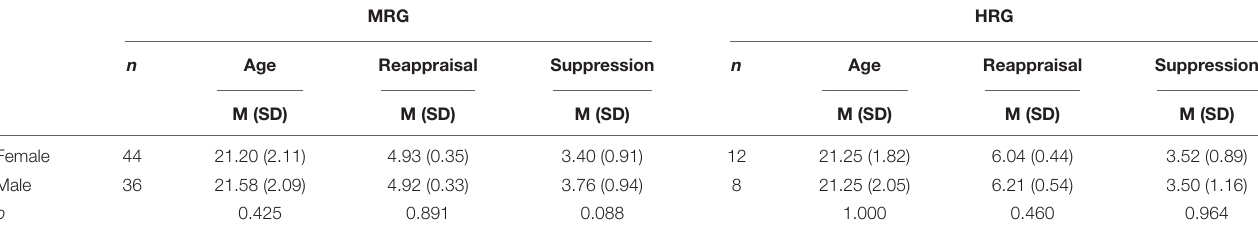
TABLE 1 | Demographic characteristics and behavioral